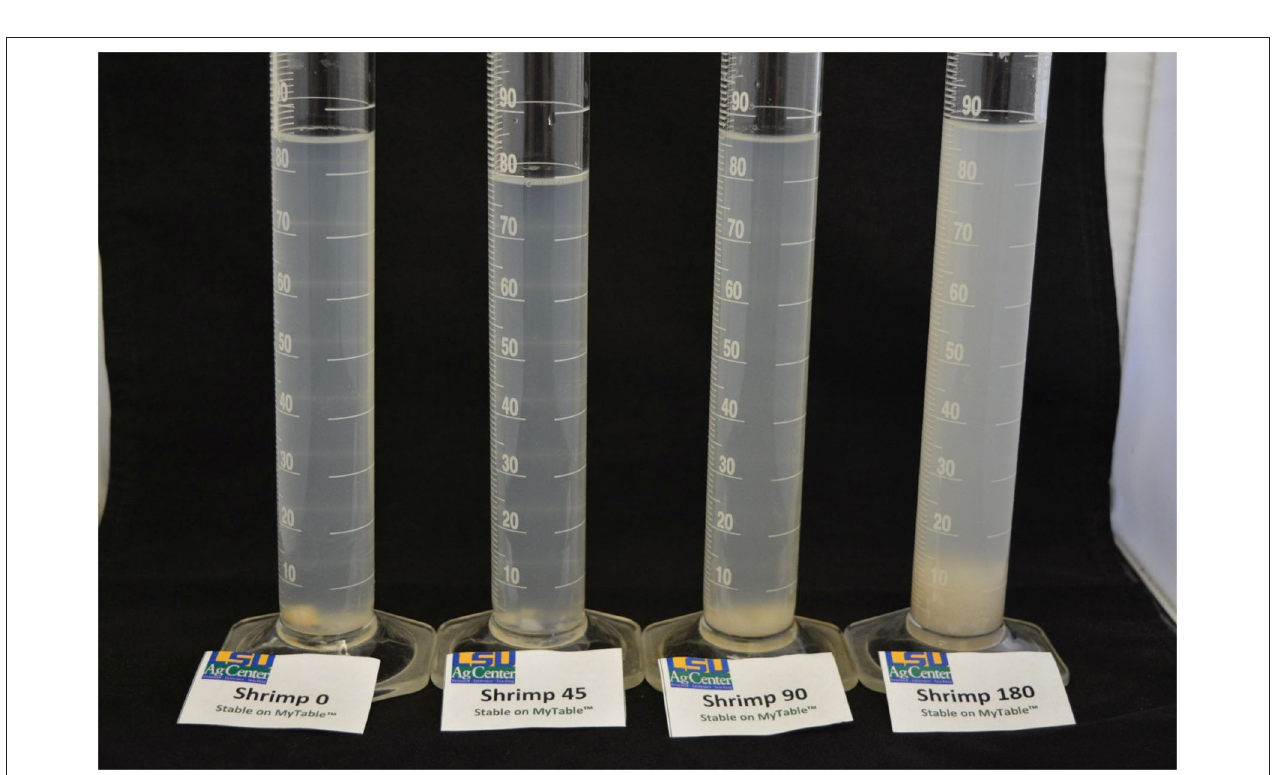
FIGURE 9 | Louisiana Gulf Coast (LGC) brown shrimp filtrate and sediment, retort thermally processed at 0, 45, 90, and 180 SPM.